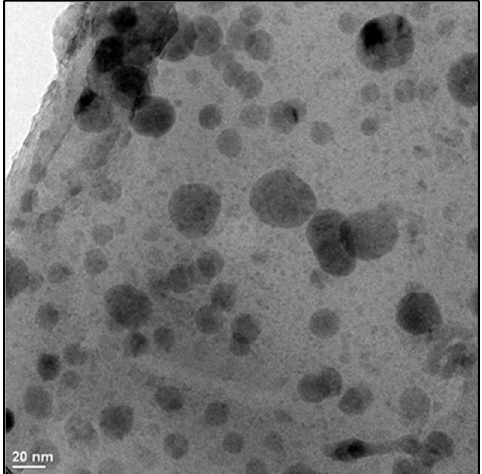
Figure 8. A TEM image of the selenium nanoparticles.